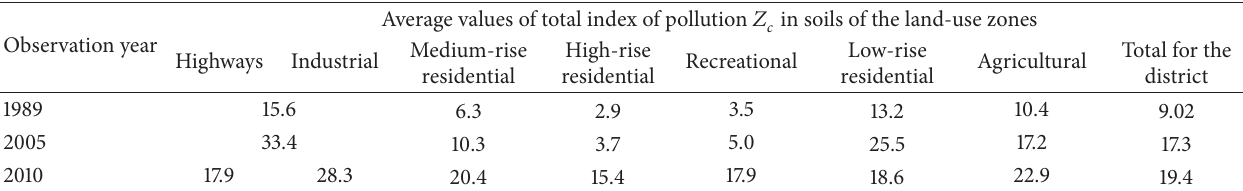
Table 4: Long-term dynamics of total HM pollution of soils in the Eastern district of Moscow depending on the type of their use. Observation